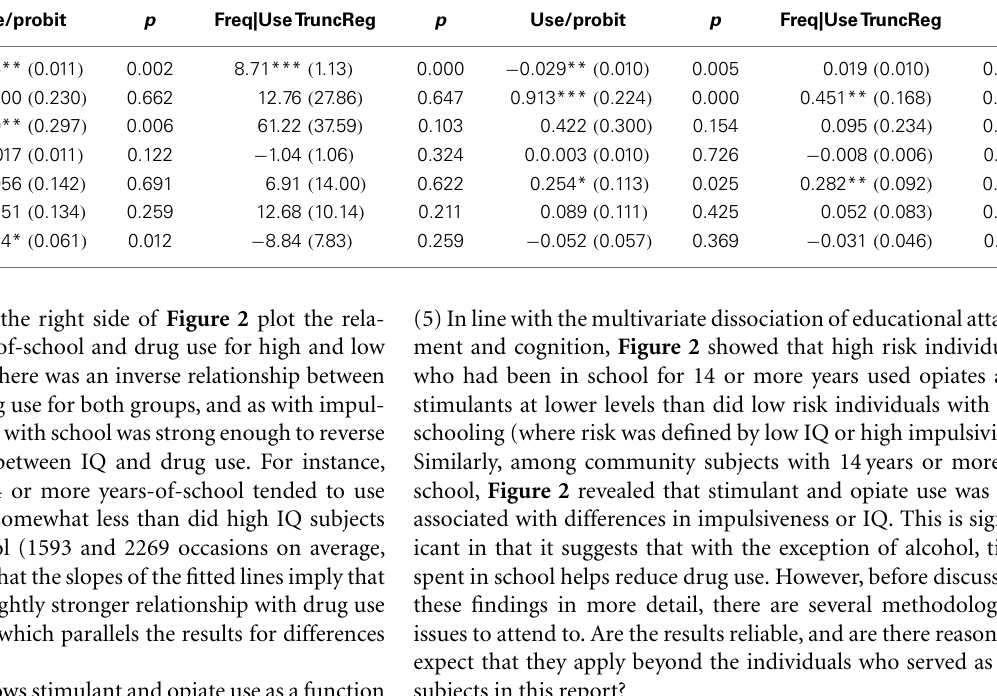
Table 4 | Double-Hurdle (Cragg’s) regression analysis: coefficients, robust standard errors, and significance .